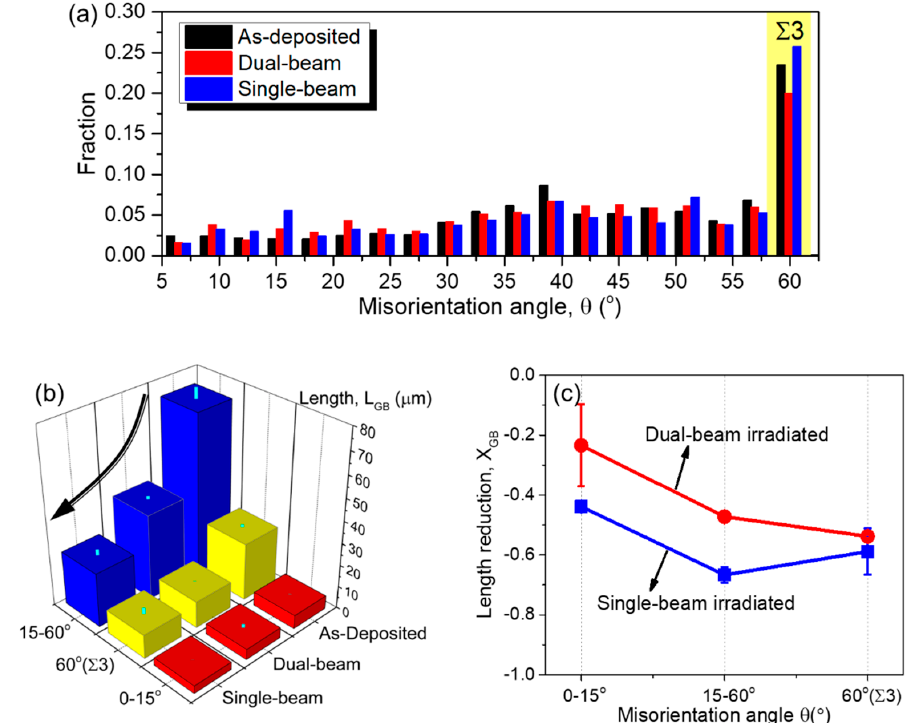
Figure 5. ( a ) Misorientation angle ( θ ) histograms for as-deposited (black), single-beam irradiated (blue), and dual-beam irradiated (red) samples. ( b ) Boundary length for low-angle (red bars, θ = 0–15°) and high-angle (blue bars, θ = 15–60°) GBs, as well as Σ 3 twin boundaries (TBs) (yellow bars, θ = 60°). ( c ) GB length reduction for dual-beam (red) and single-beam (blue) irradiated samples, relative to the as-deposited sample. Table 1. Summary of grain size and GB characters for as-deposited, dual-beam irradiated, and single- beam irradiated NC Cu, collected from a large area (11.06 μ m 2 ) at three different locations. 𝐷 (cid:2868).(cid:2873) : the median grain size when P = 0.5.